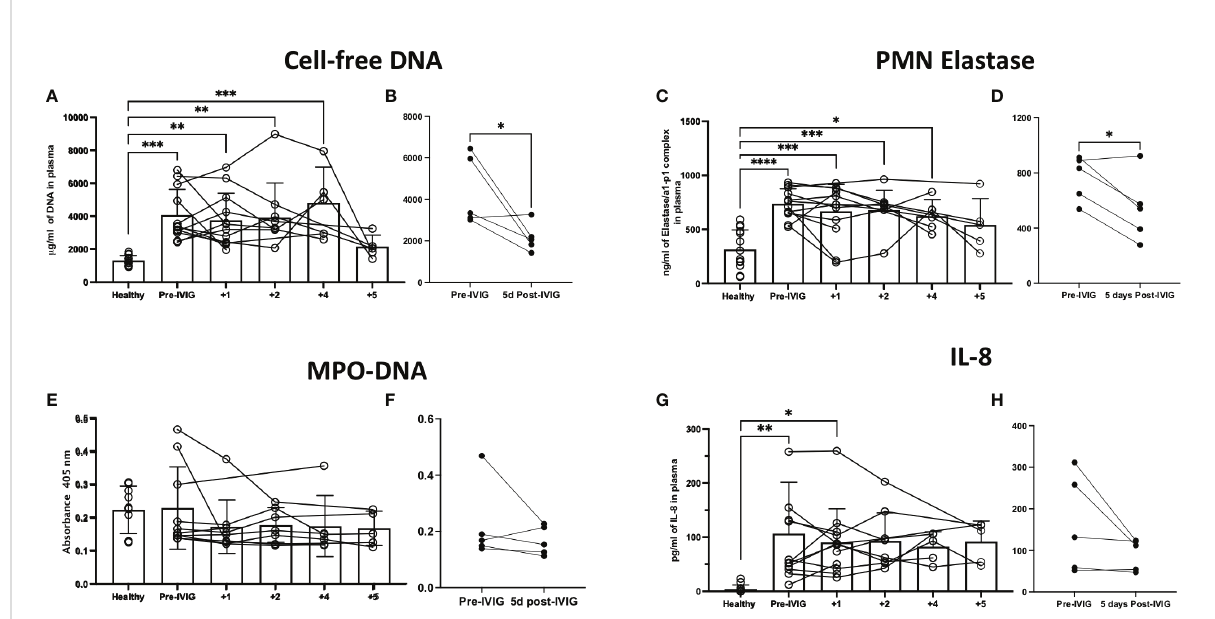
FIGURE 3 Treatment of severe COVID-19 with IVIG may lead to decreased NET-related factors and IL-8 in the circulation of patients. We assessed NET related components in the circulation of IVIG-treated COVID-19 patients, hours before the fi rst IVIG dose and up to 5 days after treatment with IVIG. Moreover, we did a paired comparison of pre-IVIG plasma versus 5 days post-IVIG. We assessed NET components such as cell-free DNA (A, B) , neutrophil elastase (C, D) , and myeloperoxidase (MPO)-DNA complexes (E, F) . Cell-free DNA and neutrophil elastase were signi fi cantly elevated in COVID-19 patients relative to controls (A, C) , and decreased after IVIG treatment (B, D) . MPO-DNA was not elevated in the plasma of patients with severe COVID-19 and did not change after IVIG treatment (E, F) . The neutrophil chemokine and activating cytokine IL-8 was elevated in the plasma of COVID-19 patients (G) but did not signi fi cantly decrease after IVIG treatment (H) . Data for panels A, C, E, and G was analyzed via one-way ANOVA with Tukey ’ s multiple comparisons test, although data points from same patients are connected to observe data trends. Data for panels B, D, F and H was analyzed with paired t-tests. Data are presented as individual data points ± SD with healthy controls (n = 10-14) and COVID-19 (n = 12). Error bars represent 95% con fi dence interval. *P < .05, **P < .01, ***P < .001, ****P <